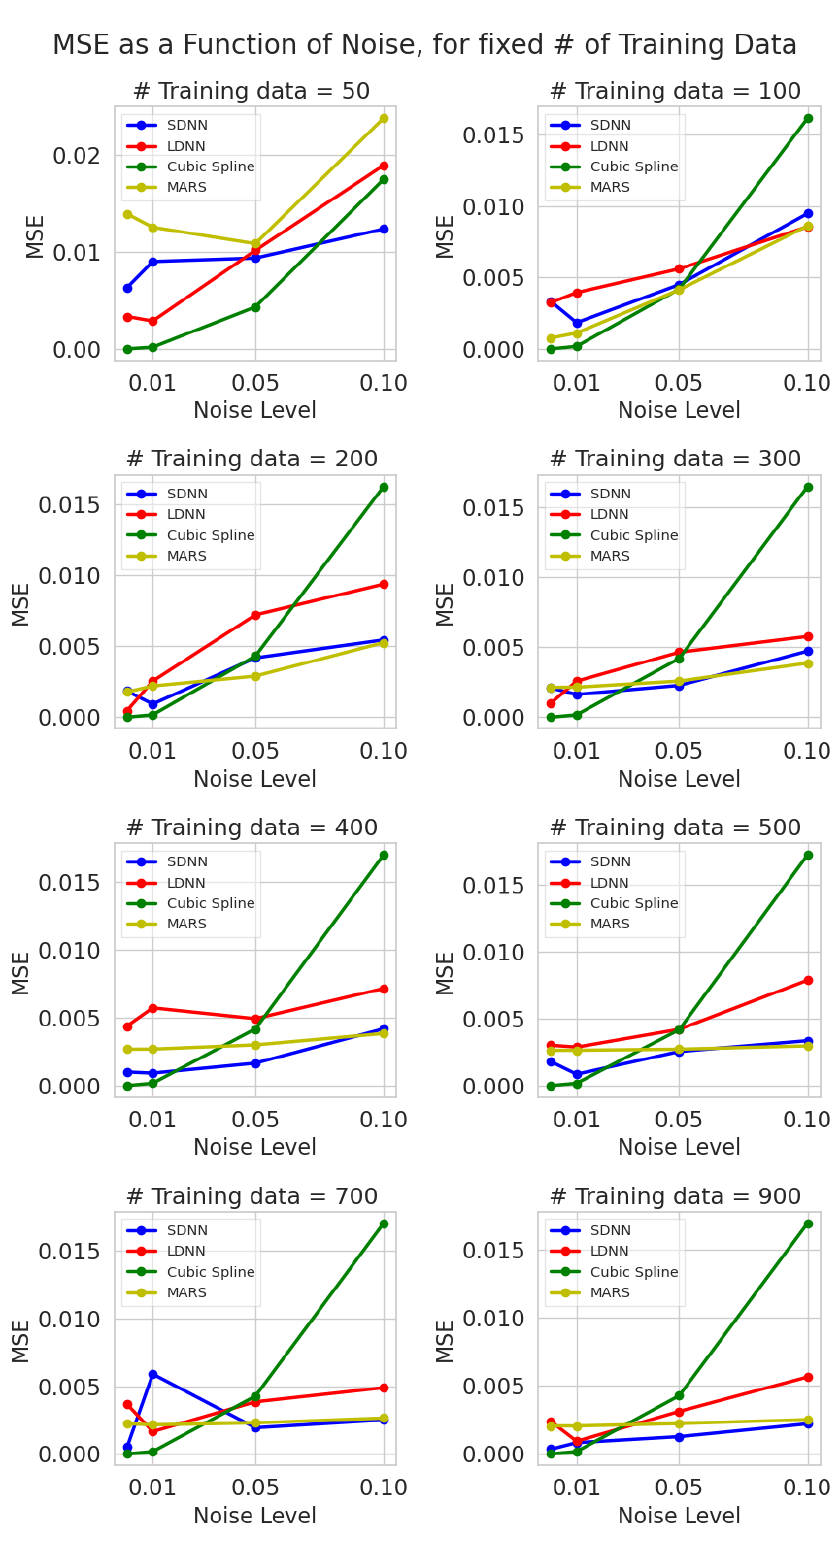
Figure 5. Test mean squared error vs. noise level (0%, 1%, 5%, 10%) for eight different levels of sparsity (sample training points). The average values over five runs are presented. Blue represents SDNN, red LDNN, green cubic splines, and yellow